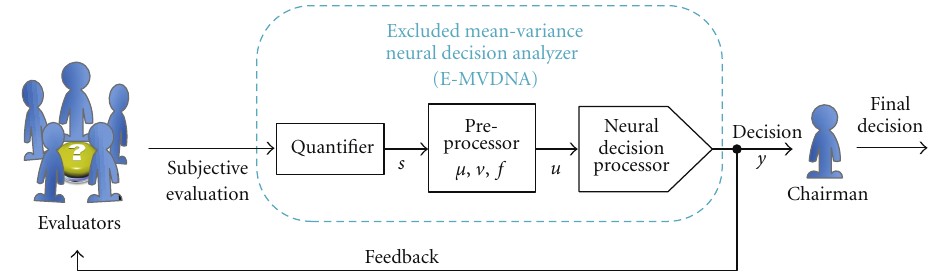
Figure 2: Flow chart of excluded-mean-variance neural decision analyzer (E-MVNDA).